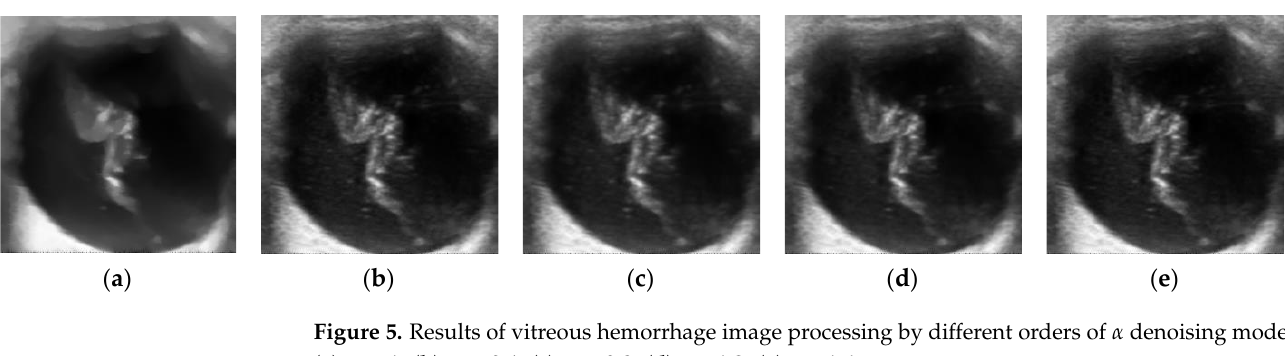
Figure 4. Experimental images. ( a ) Vitreous hemorrhage. ( b ) Vitreous mechanization.